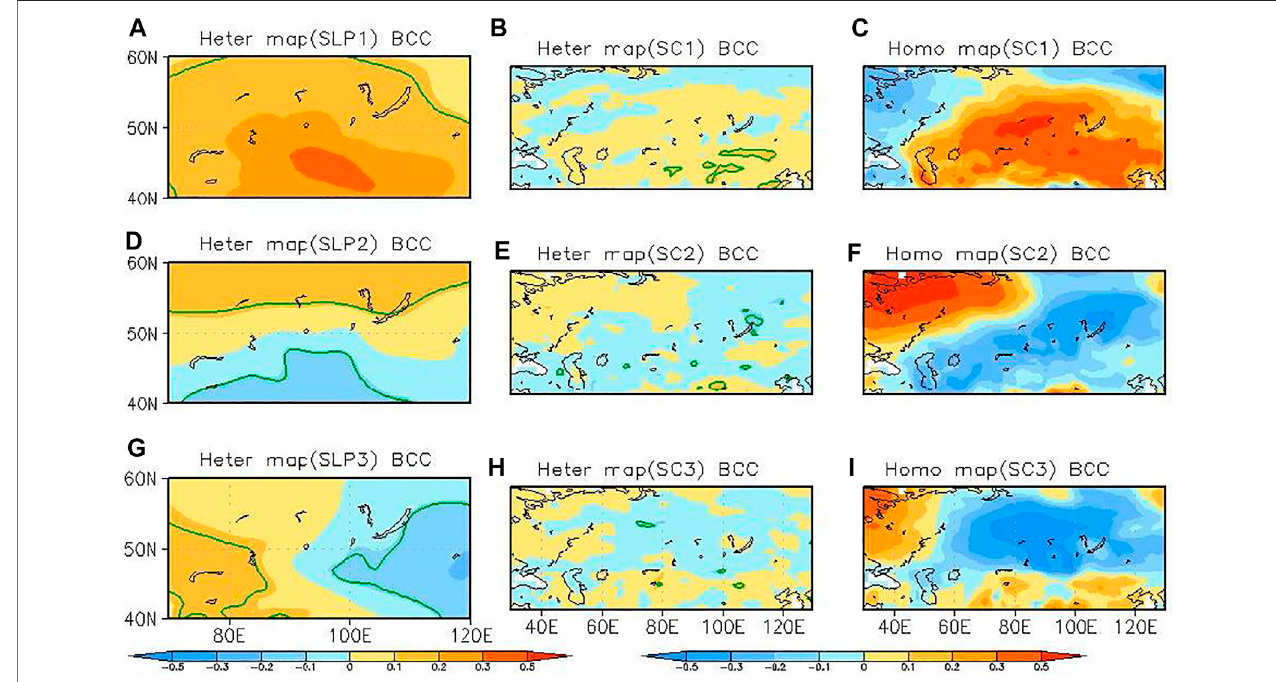
FIGURE14| Heterogeneouscorrelationcoef fi cientmapsofDJFSLP (A) ,ONsnowcover (B) ,andhomogeneousmapofONsnowcover (C) inthe fi rstSVDmode of BCC-CSM2-MR simulations. (D – F) For the second SVD mode, (D – F) for the third SVD mode. The green line indicates the value signi fi cantly exceeding the 90% con fi dence level.